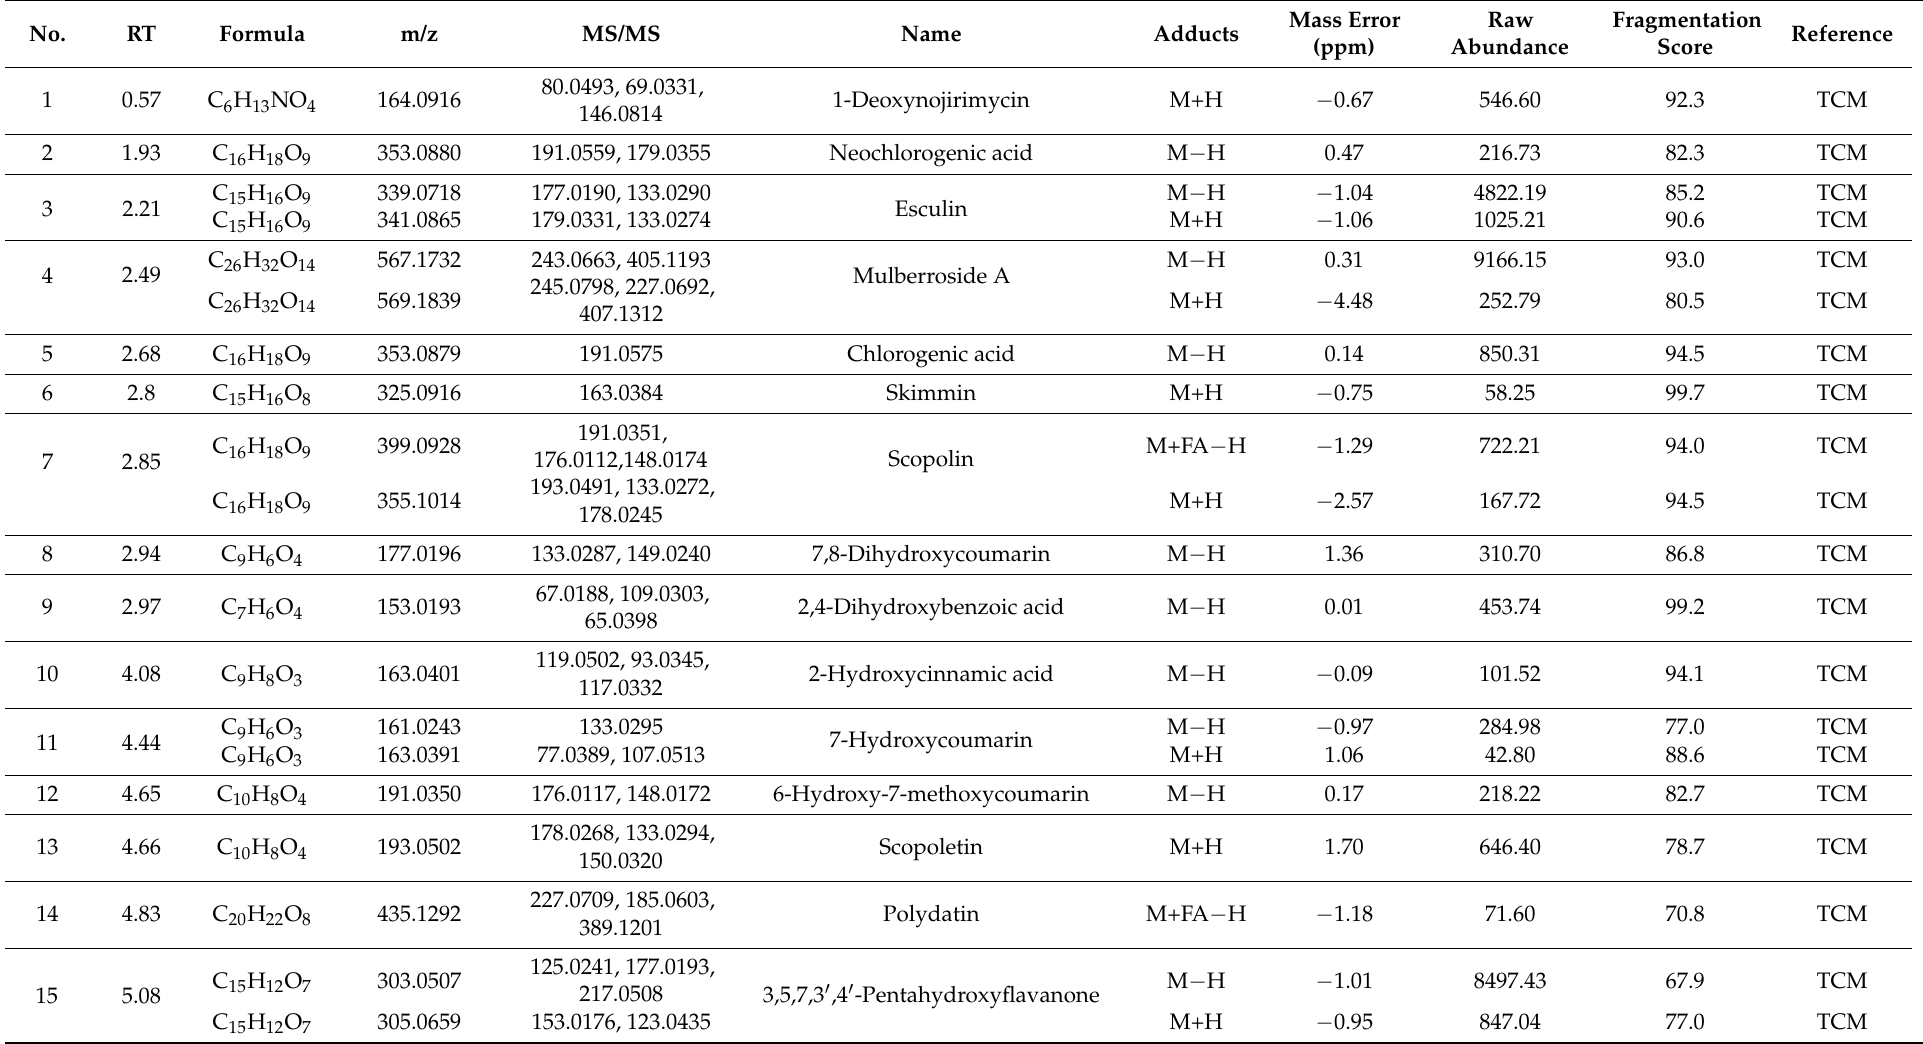
Table 1. Tentatively identified compounds from Jialing 20 ( Morus multicaulis ) mulberry branch by